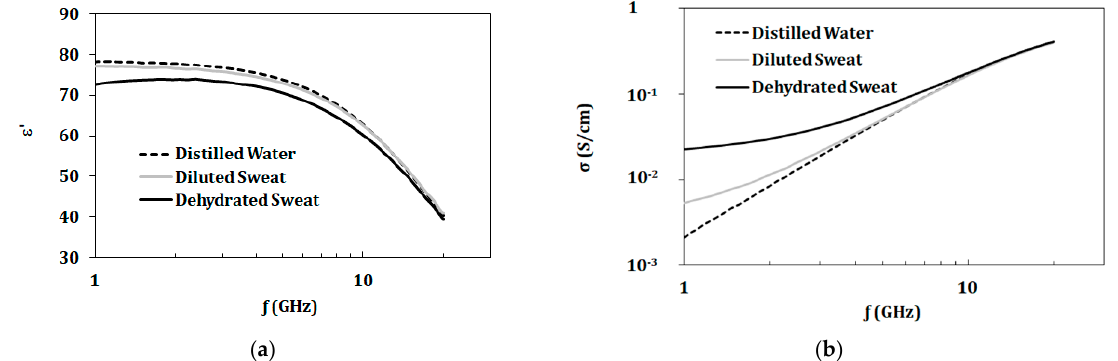
Figure 6. ( a ) Dielectric constant and ( b ) conductivity for distilled water (DW), diluted sweat (0.05% NaCl, 0.01% for each urea, lactic acid, and KCl), and dehydrated sweat (0.5% NaCl, 0.1% for each urea, lactic acid, and KCl. Table 3. Electrical properties for distilled water (DW) and artificial sweat solutions at 2.45 GHz. Tested Solution